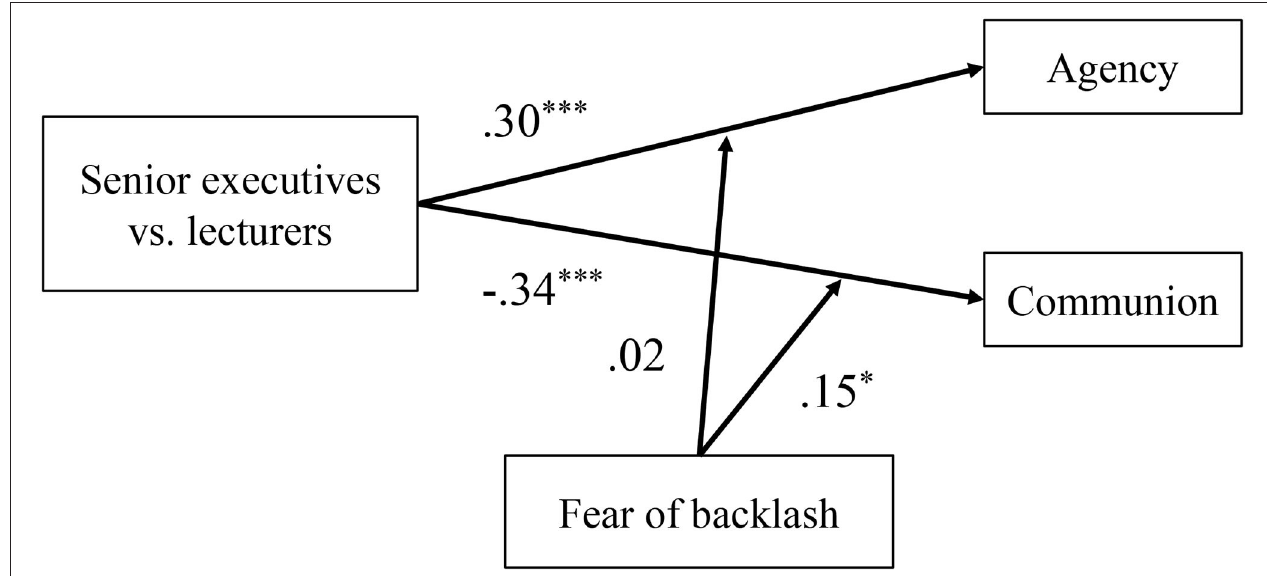
FIGURE 7 | Standardized regression coefficient for moderation effect of fear of backlash between role types and self-reported agency and communion in Study 3. Role type recoded as 1 = senior executive, 0 = lecturer. The “ + ” represents positive relationship and effect and —represents negative relationship and effect. * p < 0.05, *** p < 0.001. N = 202